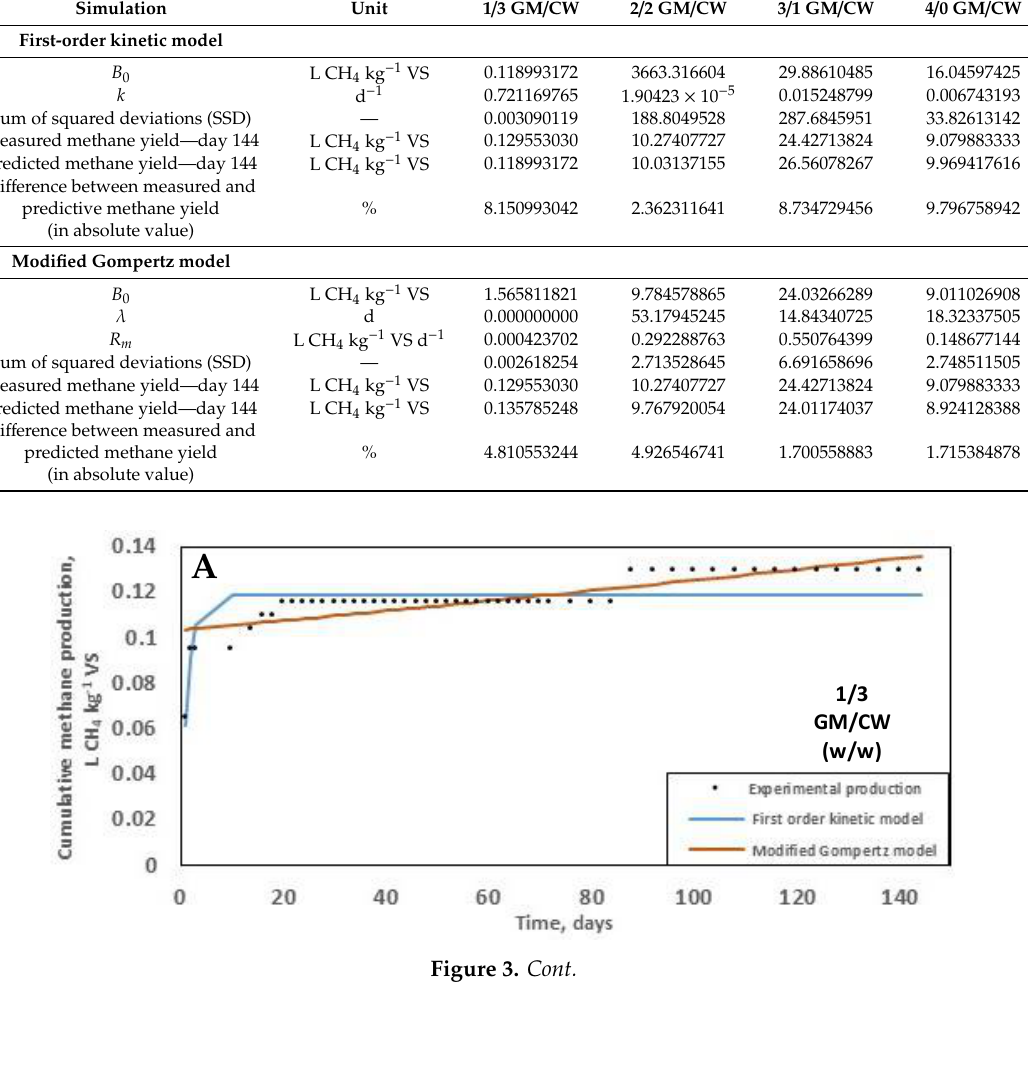
Table 2. Kinetic parameters calculated by the predictive non-linear regression models: first-order kinetic and the modified Gompertz for digesters containing: 1 / 3 GM / CW ( w / w ); 2 / 2 GM / CW ( w / w ); 3 / 1 GM / CW ( w / w ); and 4 / 0 GM / CW ( w / w ).